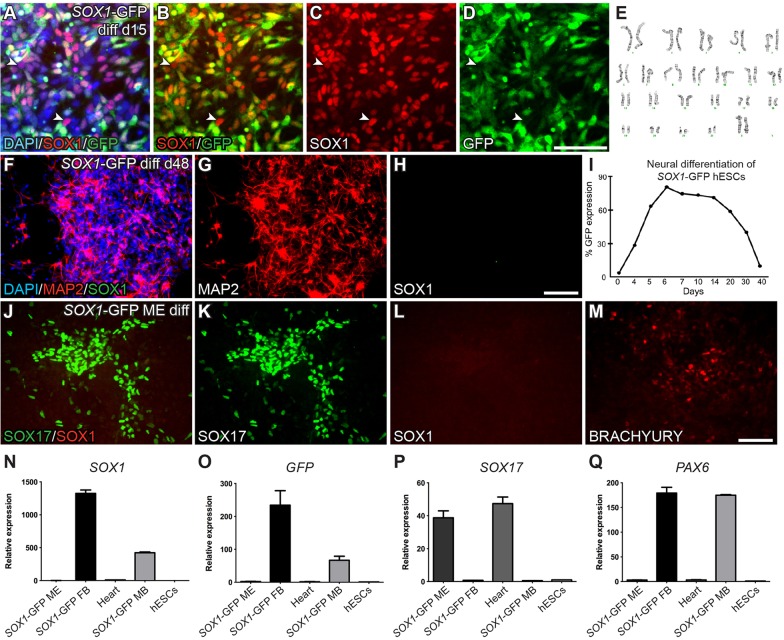
The clonal SOX1-GFP hESC line monitors differentiation of neural epithelial cells. (A-D) Upon neural induction, the clonal cell line SOX1-GFP rapidly switched on GFP, which overlapped with SOX1 expression. Only a very small fraction of the SOX1+ cells were GFP− (<2%, indicated by white arrowheads). (E) The SOX1-GFP cells retained a normal karyotype (46,xx). (F-H) As the cells were terminally differentiated, MAP2+ neurons no longer expressed SOX1. (I) The GFP expression was monitored during differentiation using FACS. GFP expression peaked around day 6 and was maintained at high levels until terminal differentiation was initiated at day 16. (J-M) Upon mesendodermal (ME) differentiation, no SOX1 was detected. Instead, cells started to express the ME markers SOX17 and BRACHYURY. (N-Q) The expression of SOX17 as well as the absence of GFP and SOX1 was confirmed with qRT-PCR. ME cells were also found negative for the neural marker PAX6. All qRT-PCR analyses were performed using three biological and three technical replicates. Data are presented as mean±s.e.m. Scale bars: 100 μm.